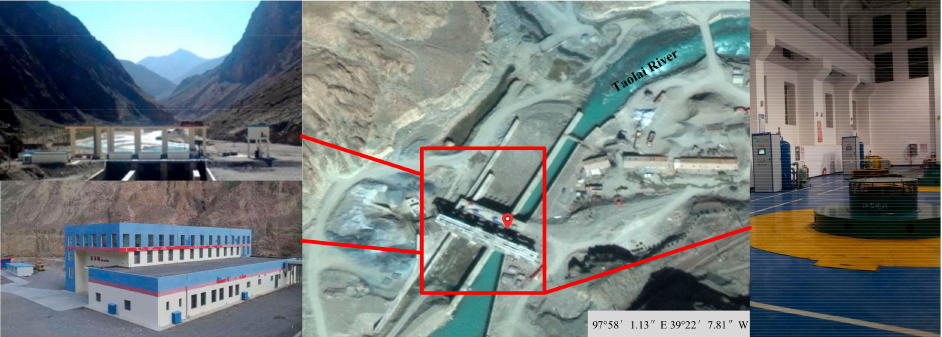
Figure 3. Dongshuixia hydropower